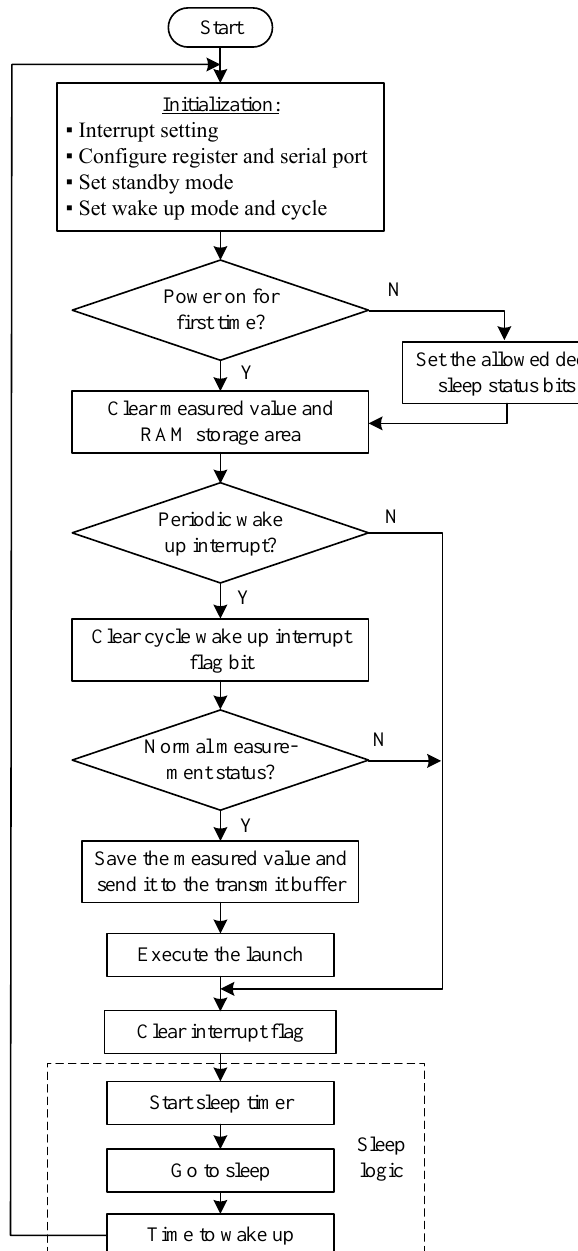
Figure 19. Flow chart of the node power-saving design software.